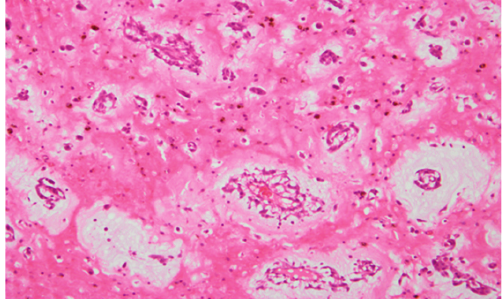
Figure 3: Microscopic features of the specimen: it composed of satellite myxoma cells, inflammatory cells, and much basophilic substance (200 ×